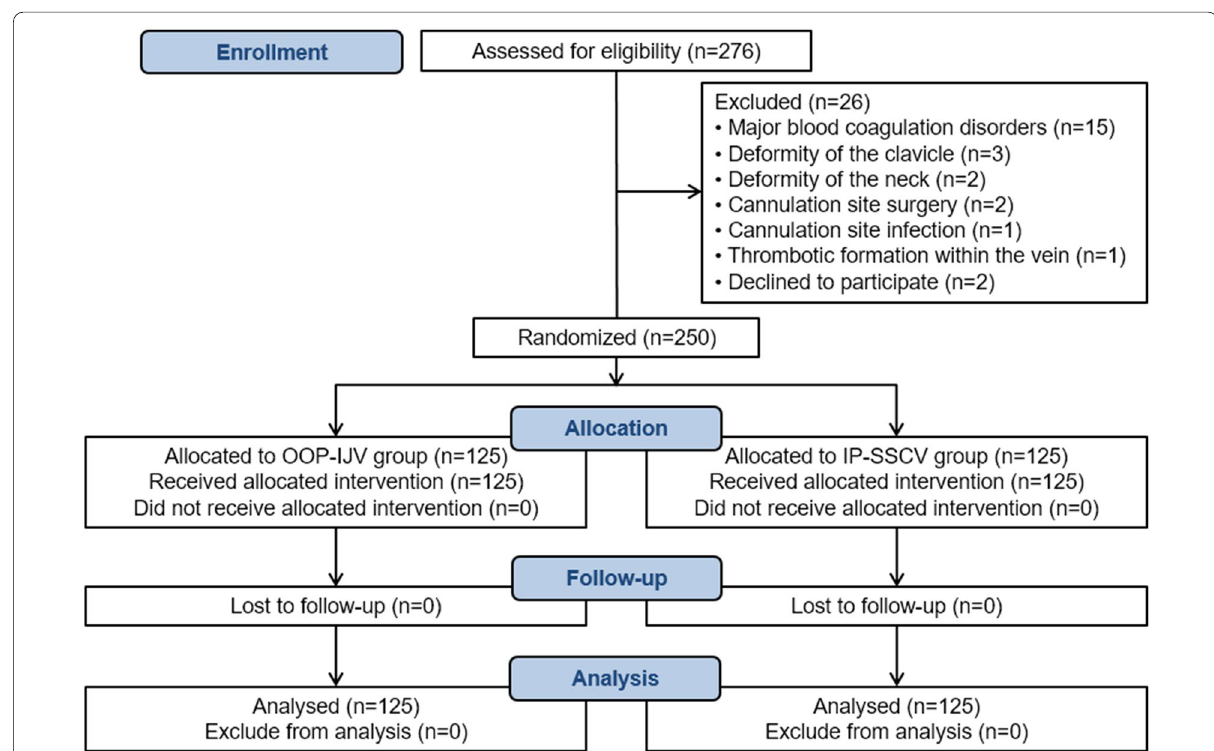
Fig. 3 CONSORT flow diagram of the study. OOP-IJV out-of-plane internal jugular vein , IP-SSCV in-plane supraclavicular subclavian vein